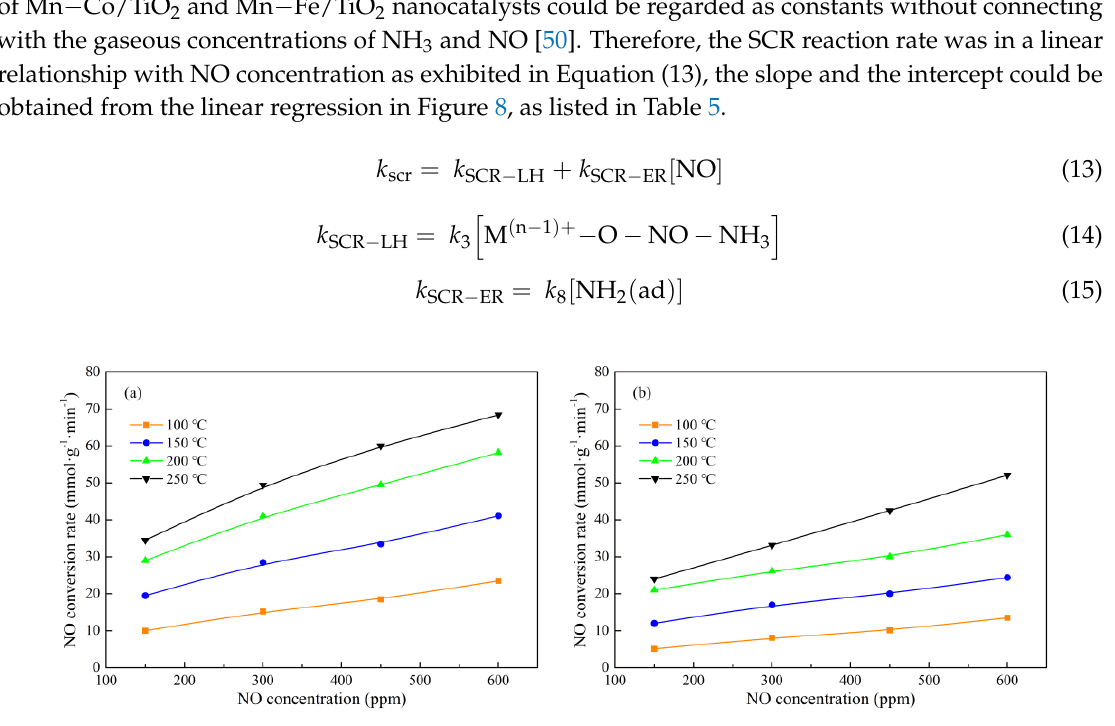
Figure 8. Effect of NO concentration on selective catalytic reduction (SCR) reaction rate. Table 5. Reaction kinetic constants of NO reduction.